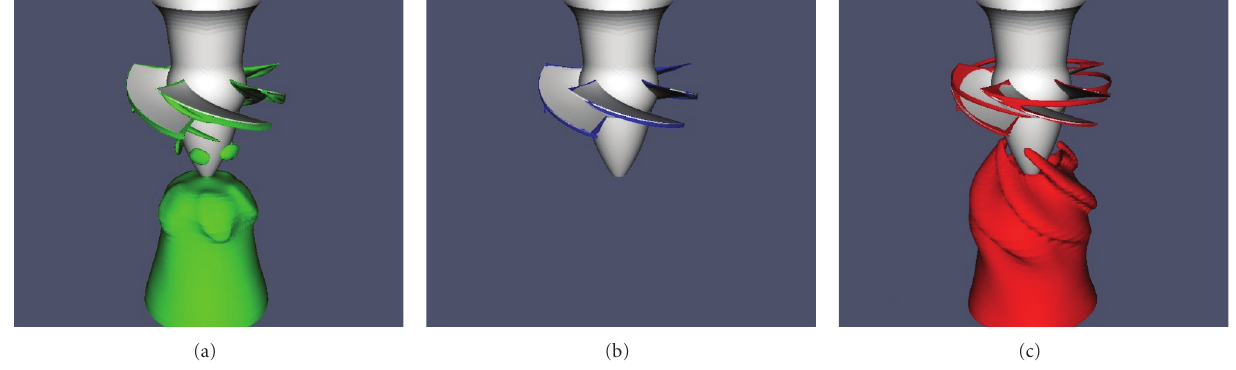
Figure 9: Iso-surface of turbulent kinetic energy, (a) 52rad / s, (b) 62rad / s, and (c) 72rad / s.